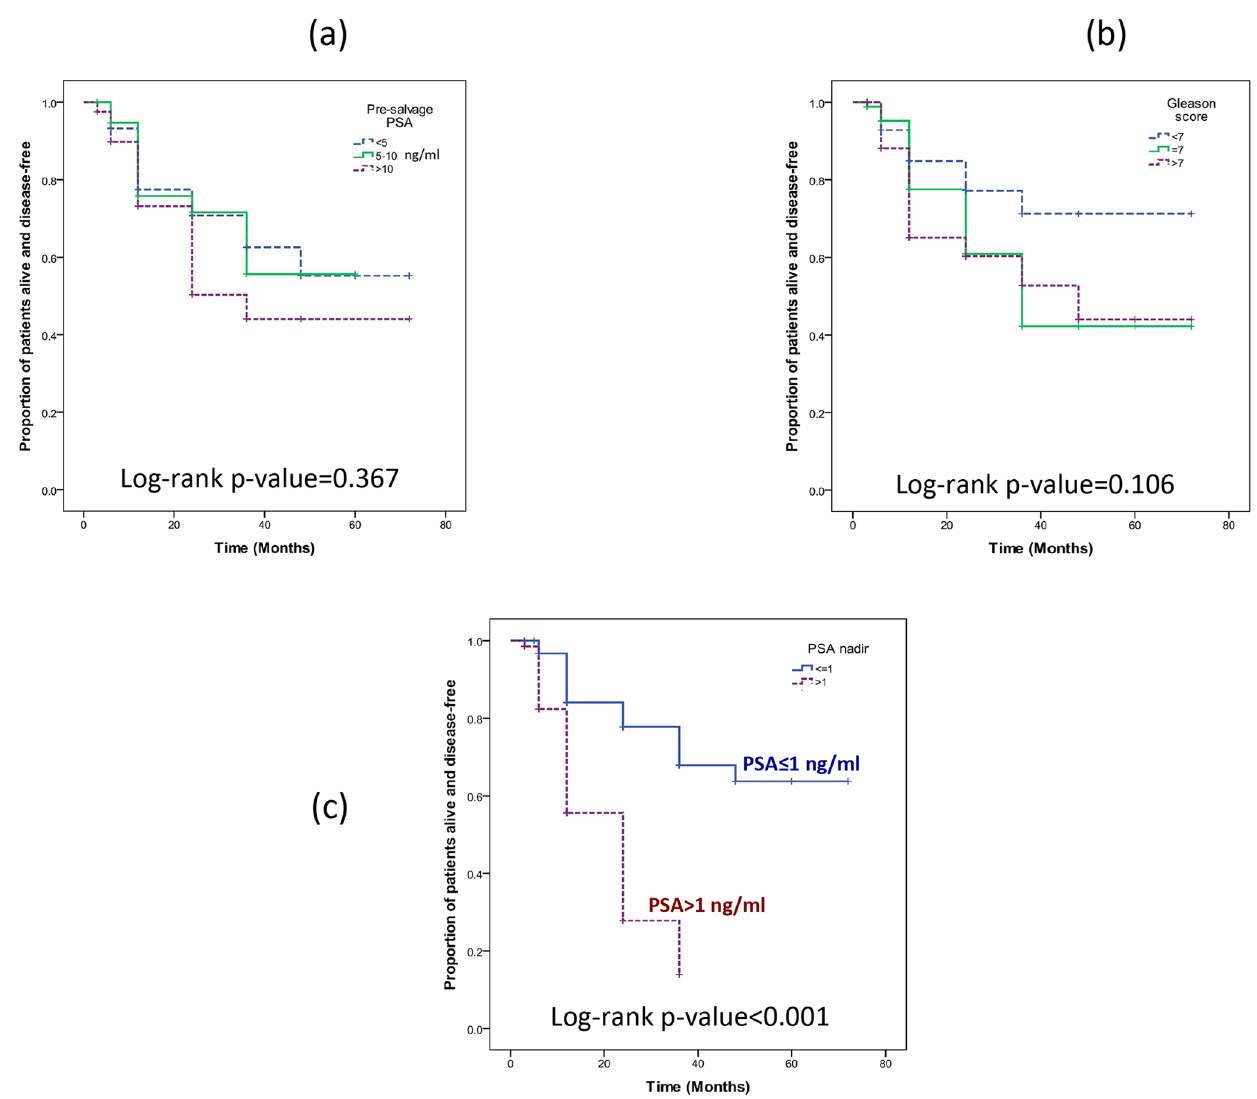
Figure 2. Disease free survival by (a) Pre-SCT PSA, (b) Gleason Score and (c) PSA nadir.